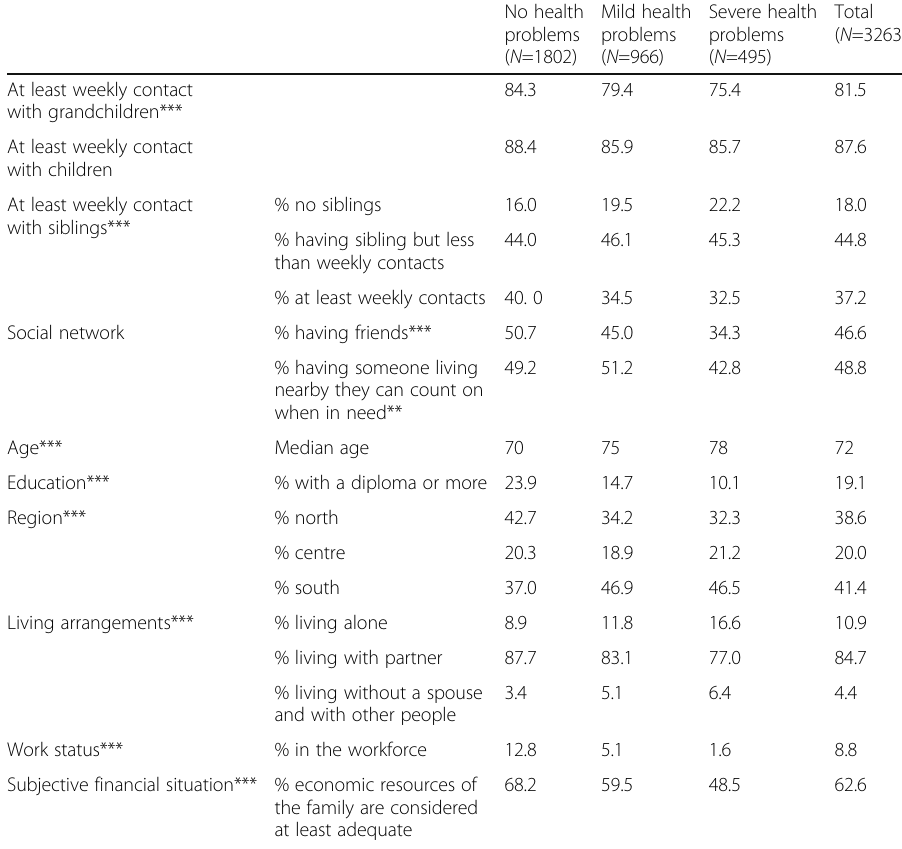
Table 3 Descriptive characteristics of grandfathers ≥ 60 years by the presence or absence of limitative health problems (data are expressed as the percentage, except for age) No health